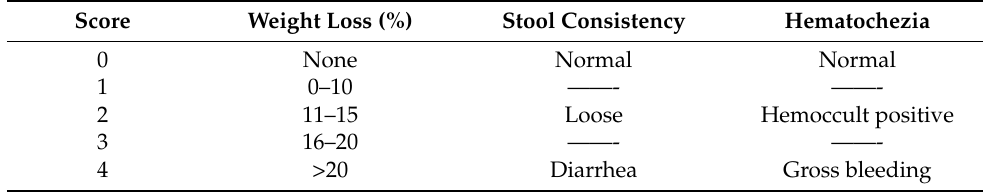
Table 1. The scoring system for the disease activity index. Score Weight Loss (%) Stool Consistency